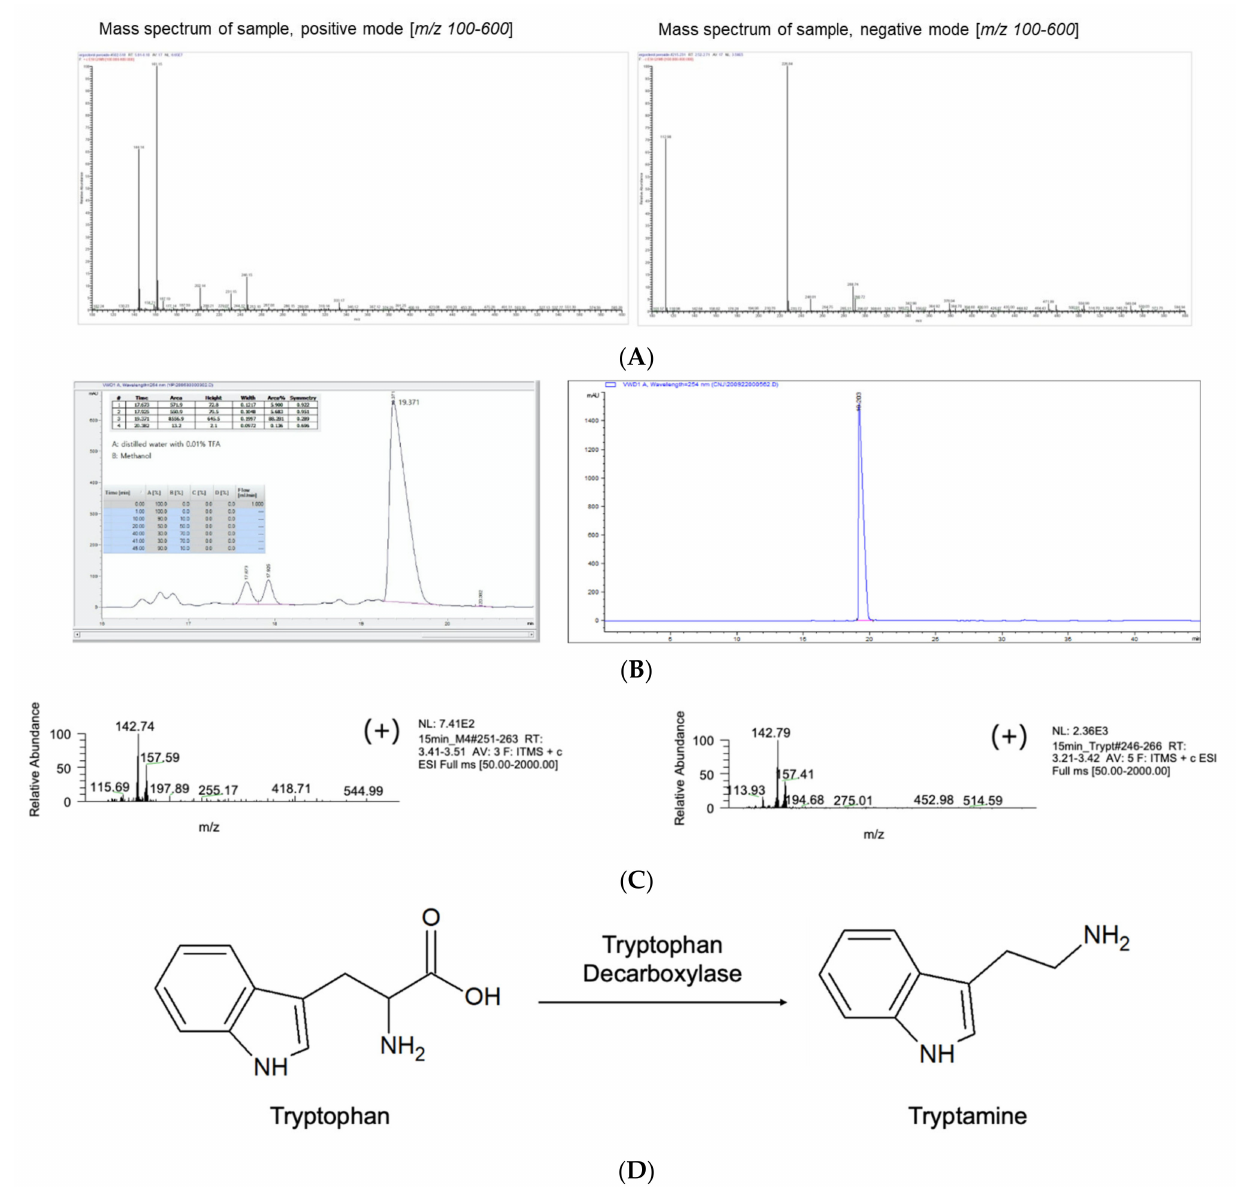
Figure 3. M4 fraction is tryptamine . ( A ) The fractions with ferrichromes and well-isolated peaks were analyzed by LC-MS to identify the molecular structure. In particular, the molecular structure of the M4 fraction was tryptamine. The mass spectrum showed typical tryptamine, and raw mass data showed that M4 was tryptamine. ( B ) To confirm the molecular structure of M4, commercial tryptamine (Sigma–Aldrich, St. Louis, MO, USA) was used as a standard molecule, and M4 and tryptamine were subjected to HPLC analysis. The left panel is M4 and the right panel is tryptamine. ( C ) Additionally, M4 and tryptamine were analyzed by LC-MS again for confirmation. The left panel is M4, the right panel is tryptamine, and the LC-MS chromatogram showed the same pattern. ( D ) The biosynthetic pathway to synthesize tryptamine from